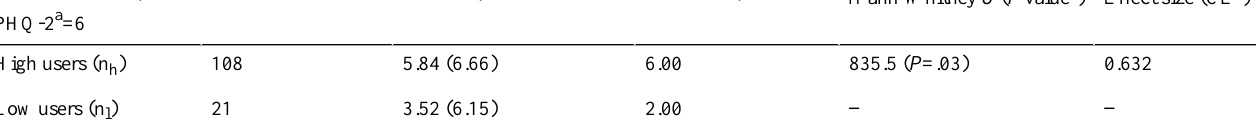
Table 2. Between-group